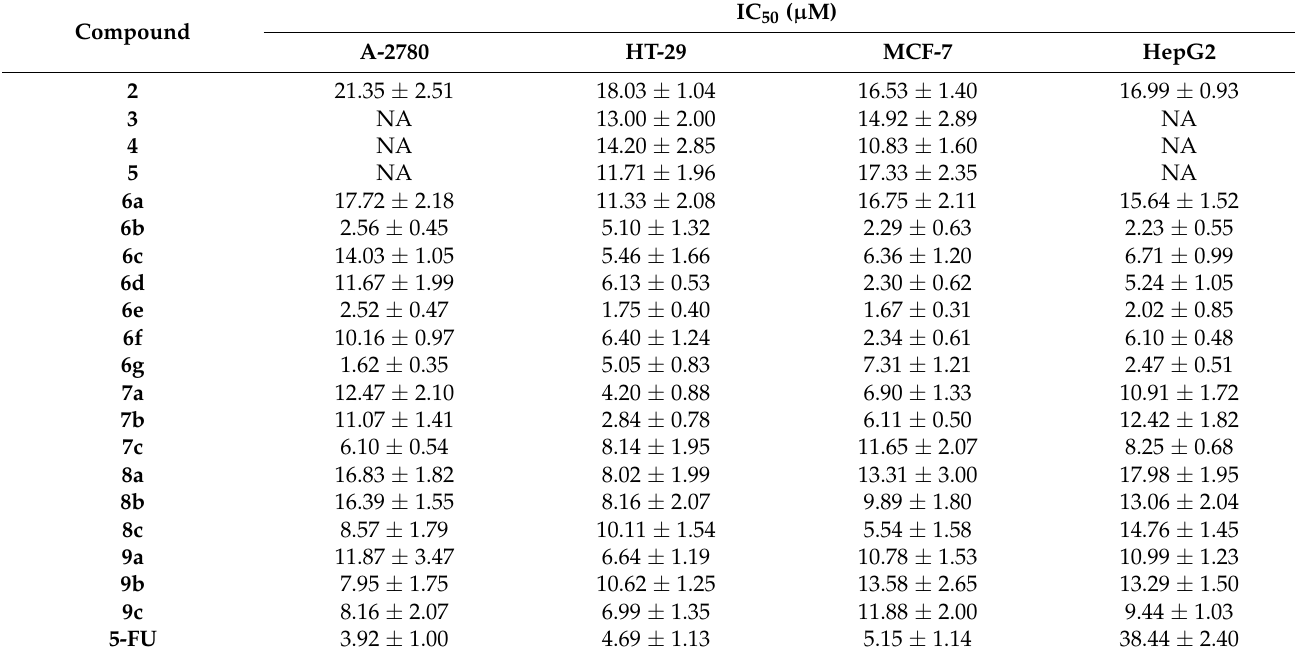
Table 1. Cytotoxic activity of the newly synthesized compounds against human cancer cells.